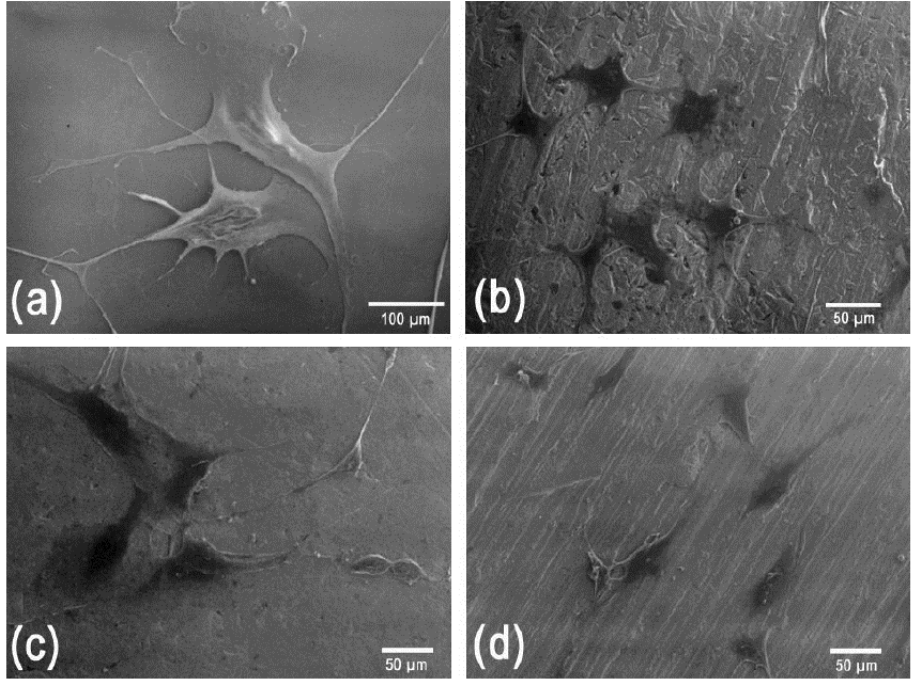
Figure 6. Scanning electron micrographs of cells grown on TNZT alloy samples doped with three amounts of oxygen. ( a ) Control samples: glass; ( b ) the TNZT #1 sample; ( c ) the TNZT #2 sample; ( d ) the TNZT #3 sample. The predominant cell shape was polygonal, with cells exhibiting a central and flattened cell body and numerous and long